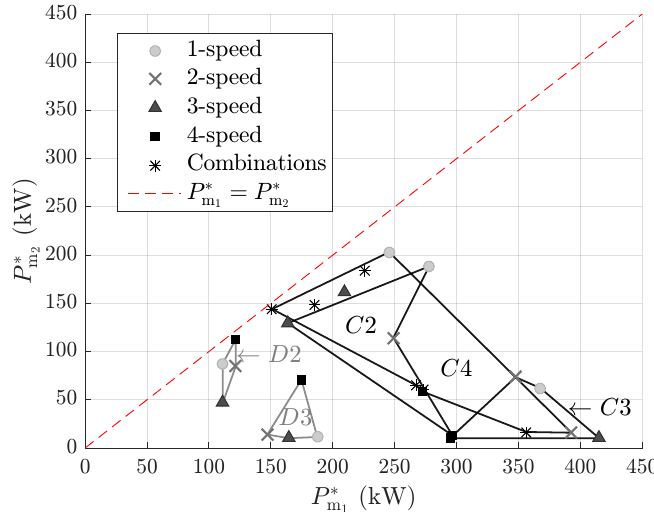
Figure 10. Electric machine sizing parameters plotted against one another. The markers indicate the gearbox type present in the topology for that specific data point. The data points belonging to the same topology are connected with lines. Gray colored lines indicated distributed topologies, and black lines indicate central drive topologies. “Combinations” refers to the configurations of T C 4 equipped with two different types of gearboxes, for example a one-speed in combination with a two-speed